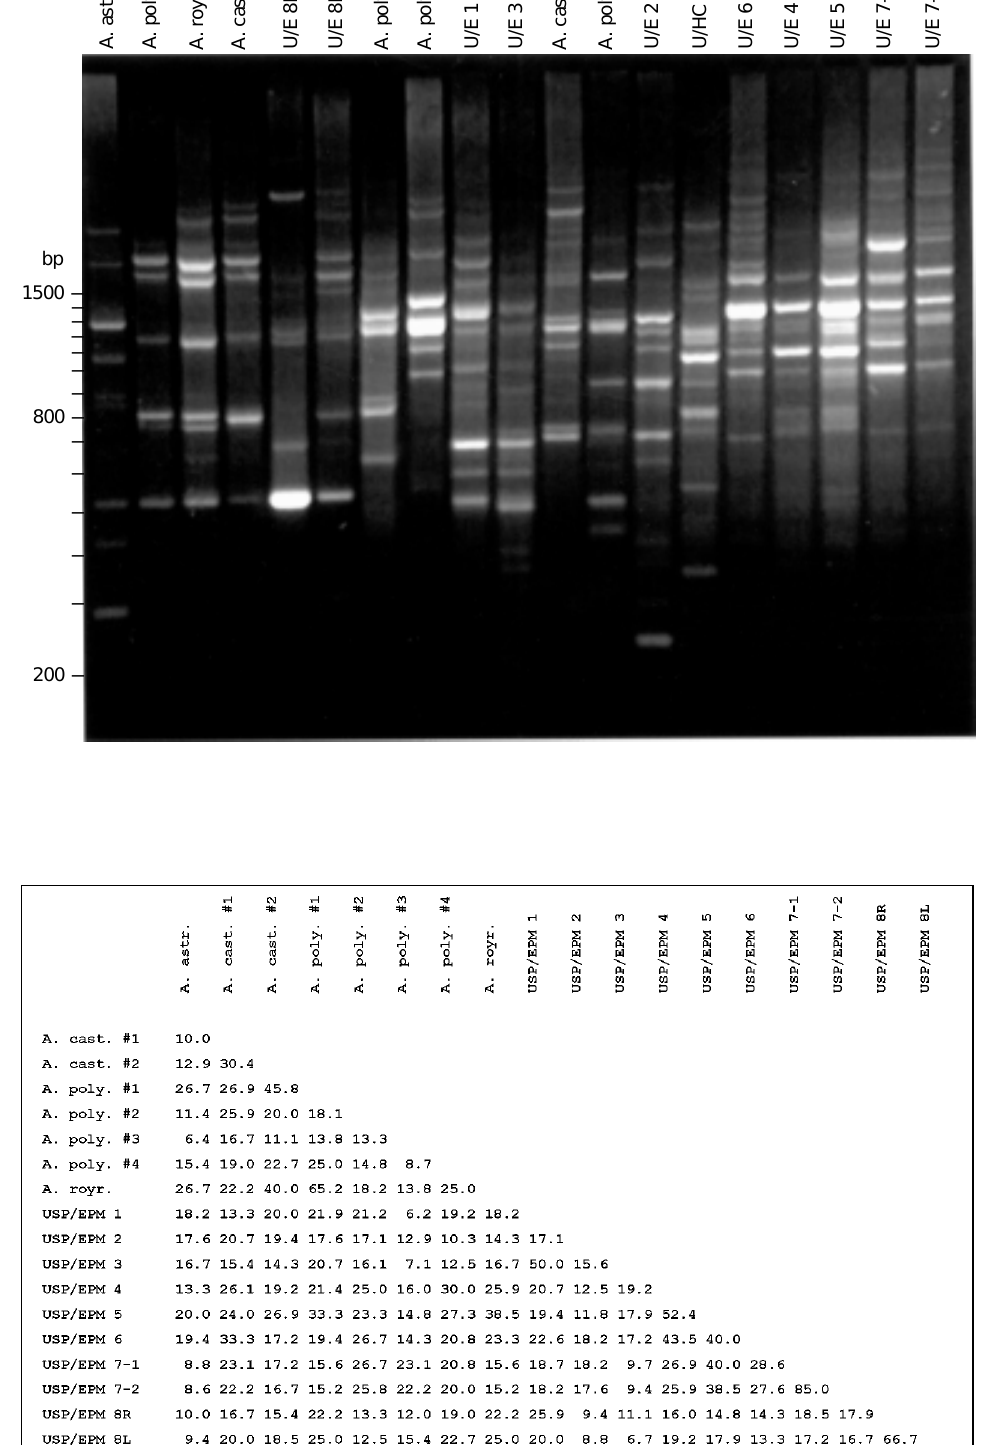
Figure 2 - RAPD profiles of 19 Acanthamoeba isolates obtained with primer 688 (5'-GCAGGA GCGT-3'). The PCR products were resolved by electrophore- sis on 2% agarose gel. Designa- tions of isolates are indicated on the top: A. astr.: A. astronyxis , A. poly.: A . polyphaga , A. cast.: A. castellanii , A. royr.: A. royreba , U/E: USP/EPM, U/HC: USP/HC. Molecular size markers (100-bp DNA ladder - Gibco BRL) are shown on the left.